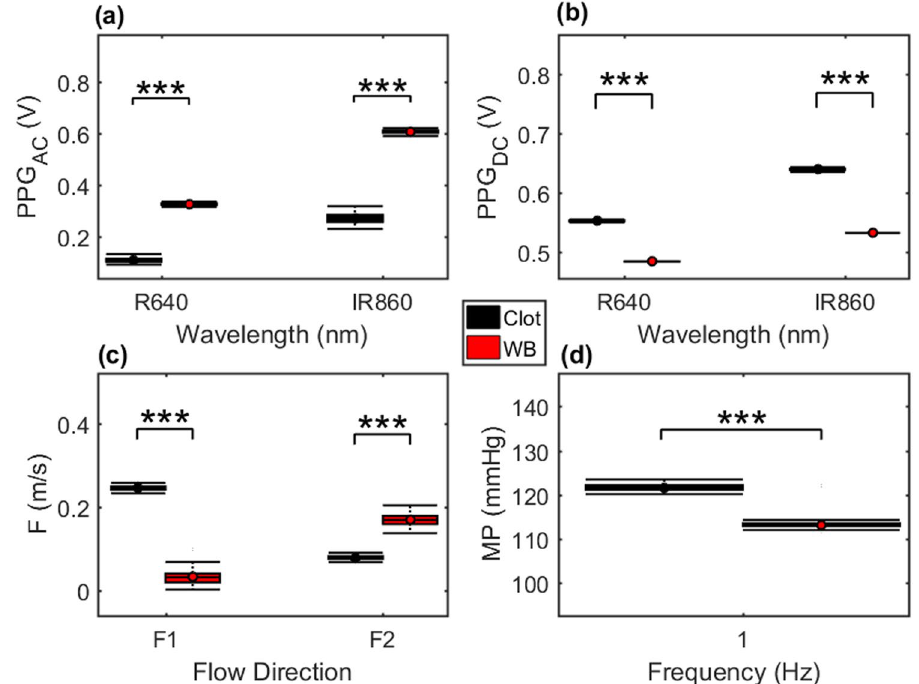
Figure 7. Statistical comparisons for PPG and haemodynamic data before and after clot formation. Data is obtained from the in vitro setup while circulating whole equine blood (WB) and after adding the clotting agent (Clot). Data obtained at a stroke volume of 70 ml and a frequency of 1 Hz. ( a ) R and IR PPG AC amplitudes, ( b ) R and IR PPG DC levels, ( c ) forward (F1) and backward (F2) flow velocities, and ( d ) mean pressure values. Statistical significance summary is displayed using the 3-star system.